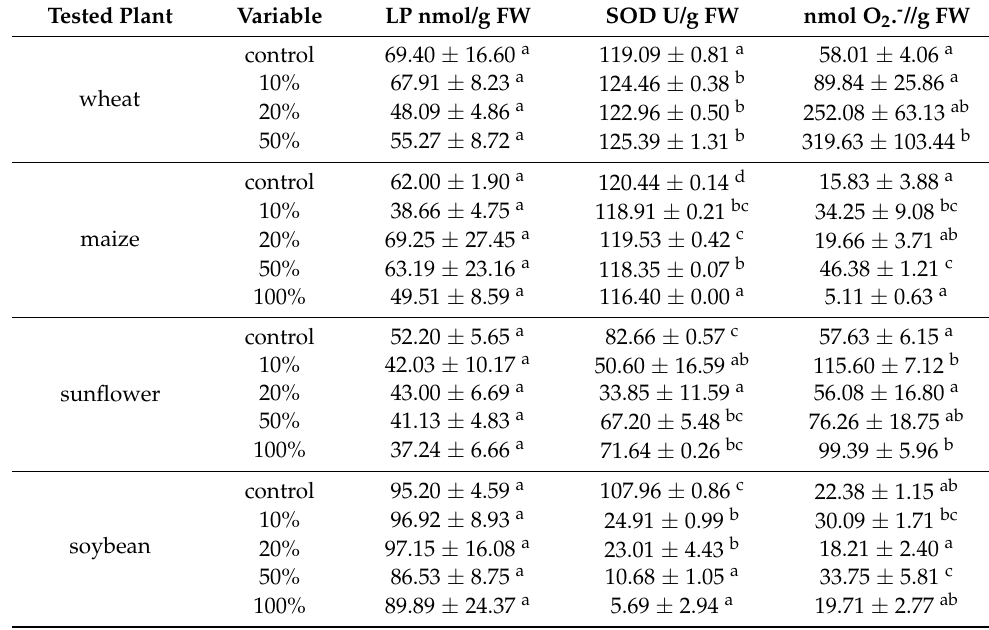
Table 5. Biochemical analysis of the treated field and vegetable crop species 14 days after the treatment. Tested